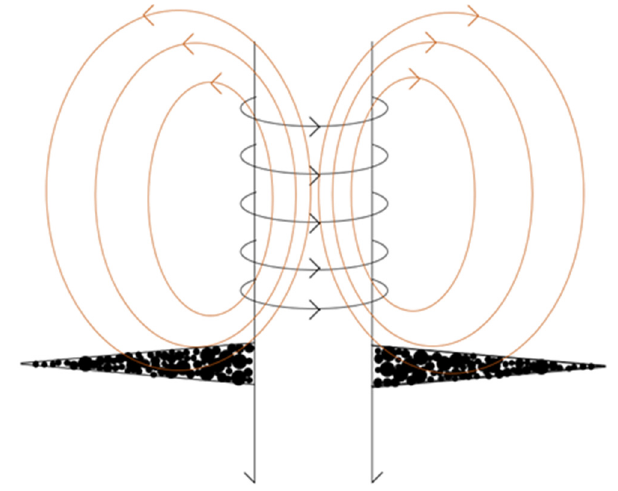
Figure 1. Simple schematic diagram of electromagnetic monitoring.